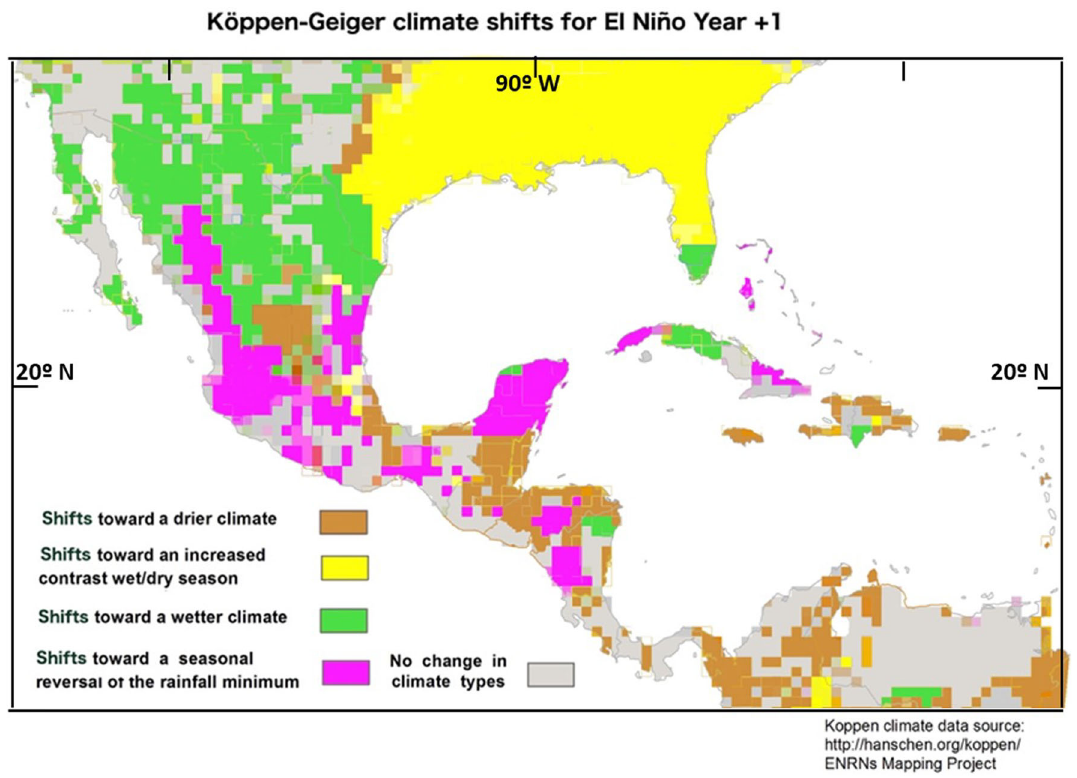
Fig. 8 Major climate shift types for rainfall regime in El Nin˜o Year ? 1 based on five strong El Nin˜os in the Central American and circum- Caribbean